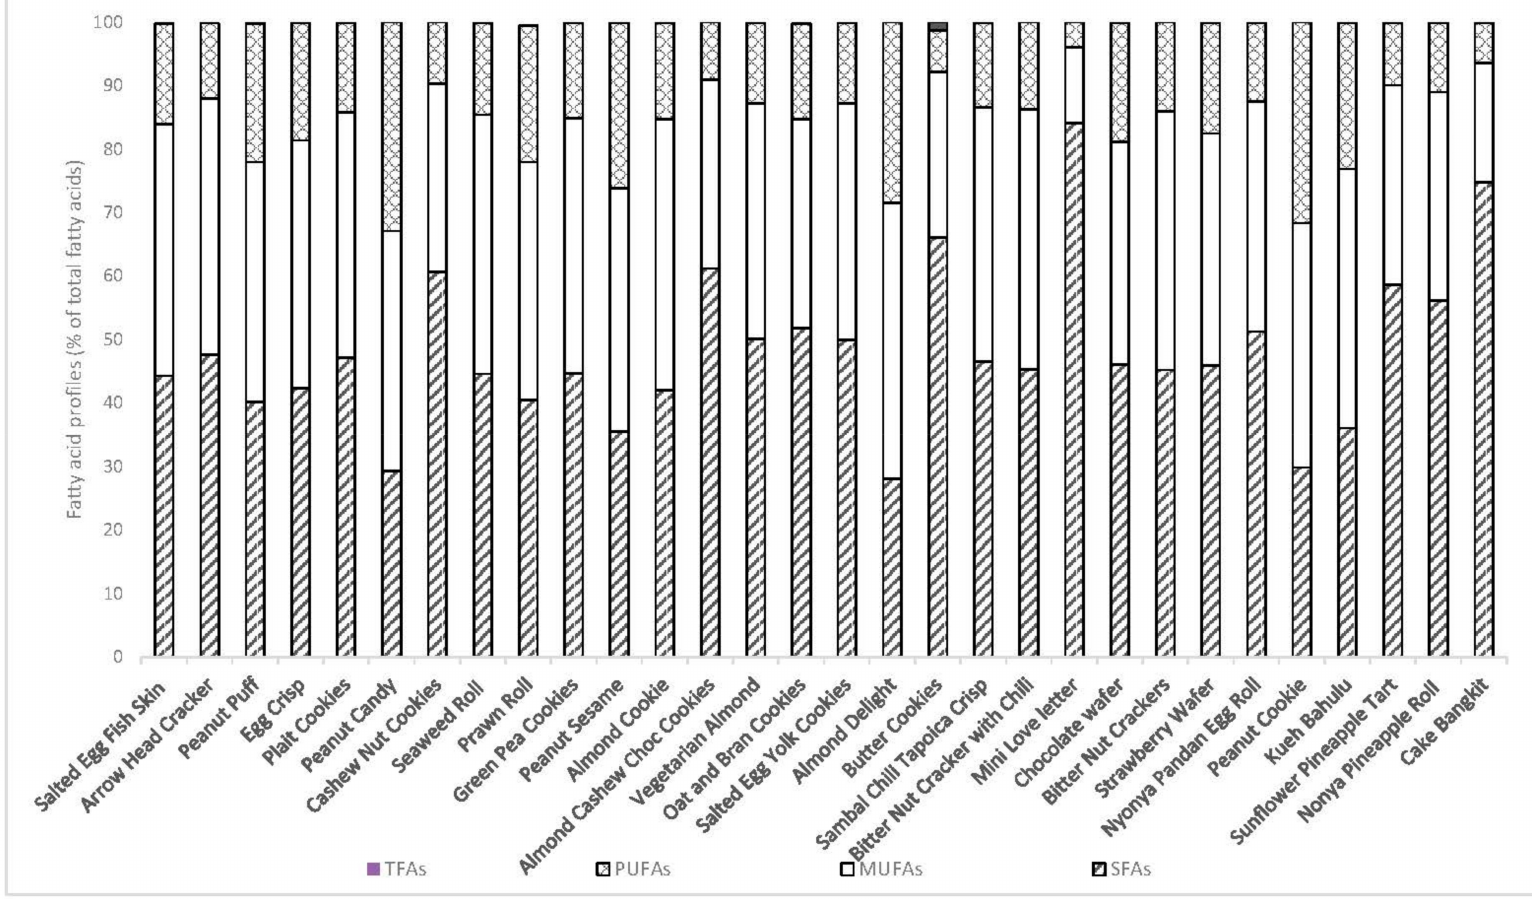
Figure 1. Fatty acid profiles (% of total fatty acids) of thirty CNY